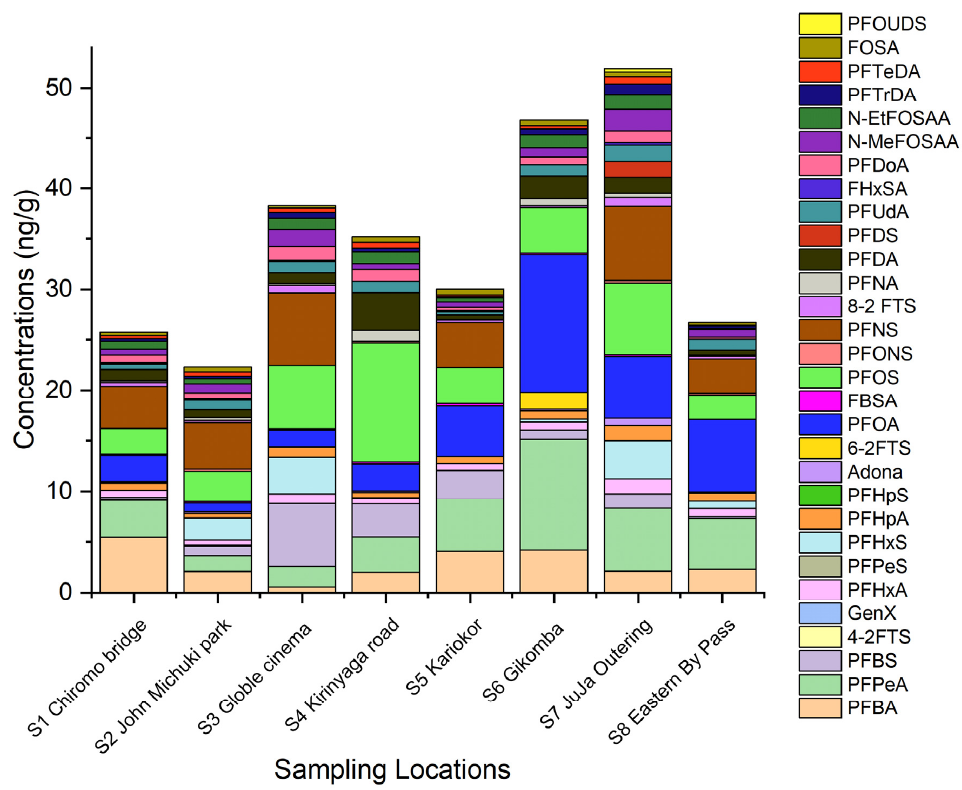
Figure 3. PFAS spatial distribution in sediments from the Nairobi River Basin.